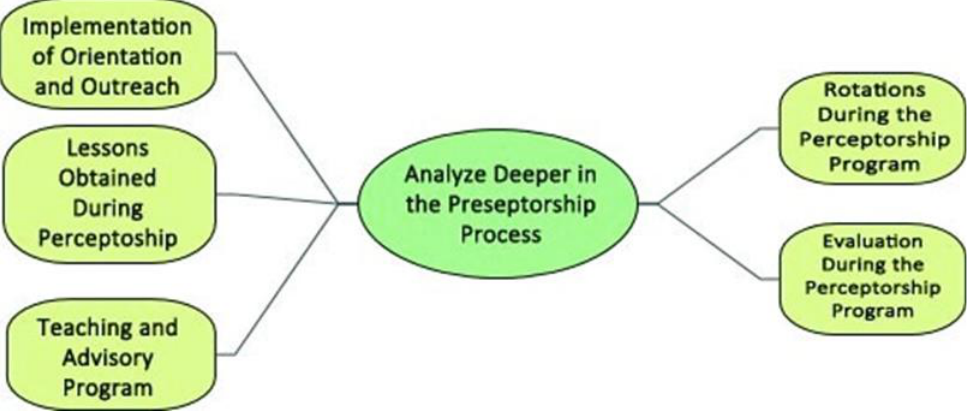
Fig. 3. Themes and sub themes of the preceptorship